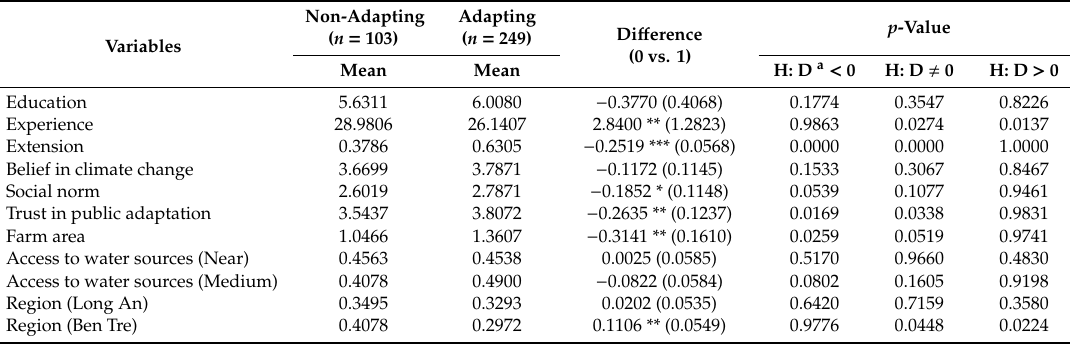
Table 2. Di ff erence between control and treatment group regarding adaptation response.